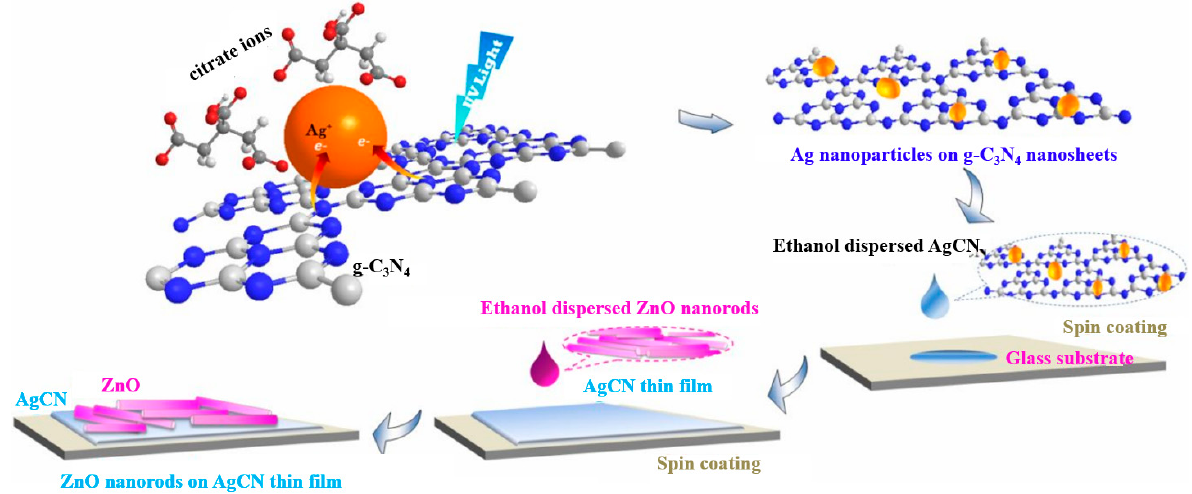
Figure 14. Schematic representation of the synthesis procedure of plasmonic hybrid heterojunctions [78].